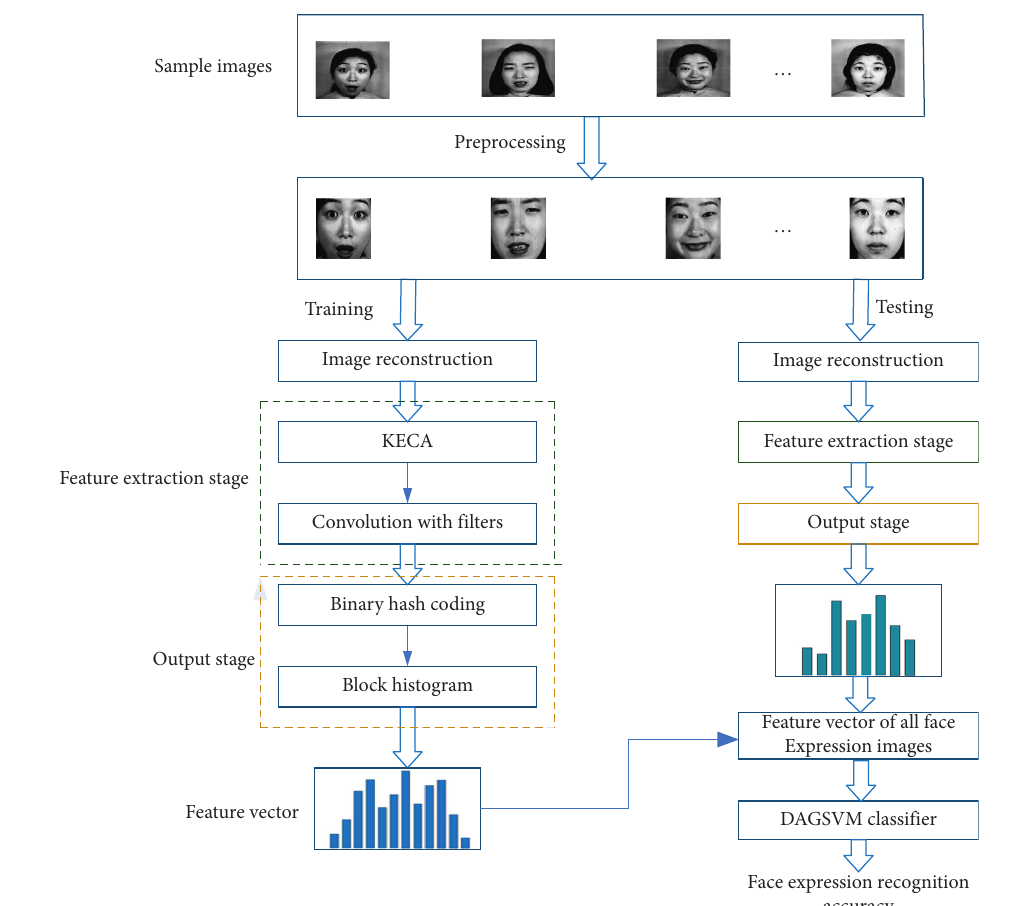
Figure 2: The flowchart of the FER based on